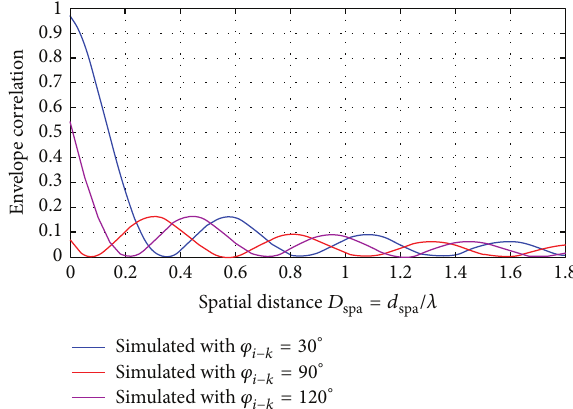
Figure 5: Combined correlation function versus spatial distance with angular difference as